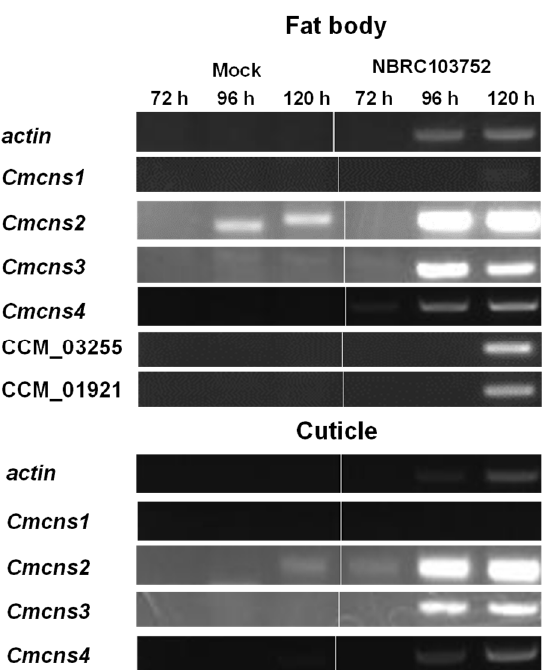
Figure 3. Expression of Cmcns genes and genes involved in the synthesis of secondary metabolites in vivo. Silkworm larvae were injected with 25 µ L of a suspension of 1 × 10 6 conidia/mL of C. militaris NBRC103752. Fat bodies and cuticles were collected at 3 to 5 days after conidia injection, and total RNA was extracted. RT-PCR was used to assess the expression of each gene. Mock indicates PBS-injection (uninfected control).